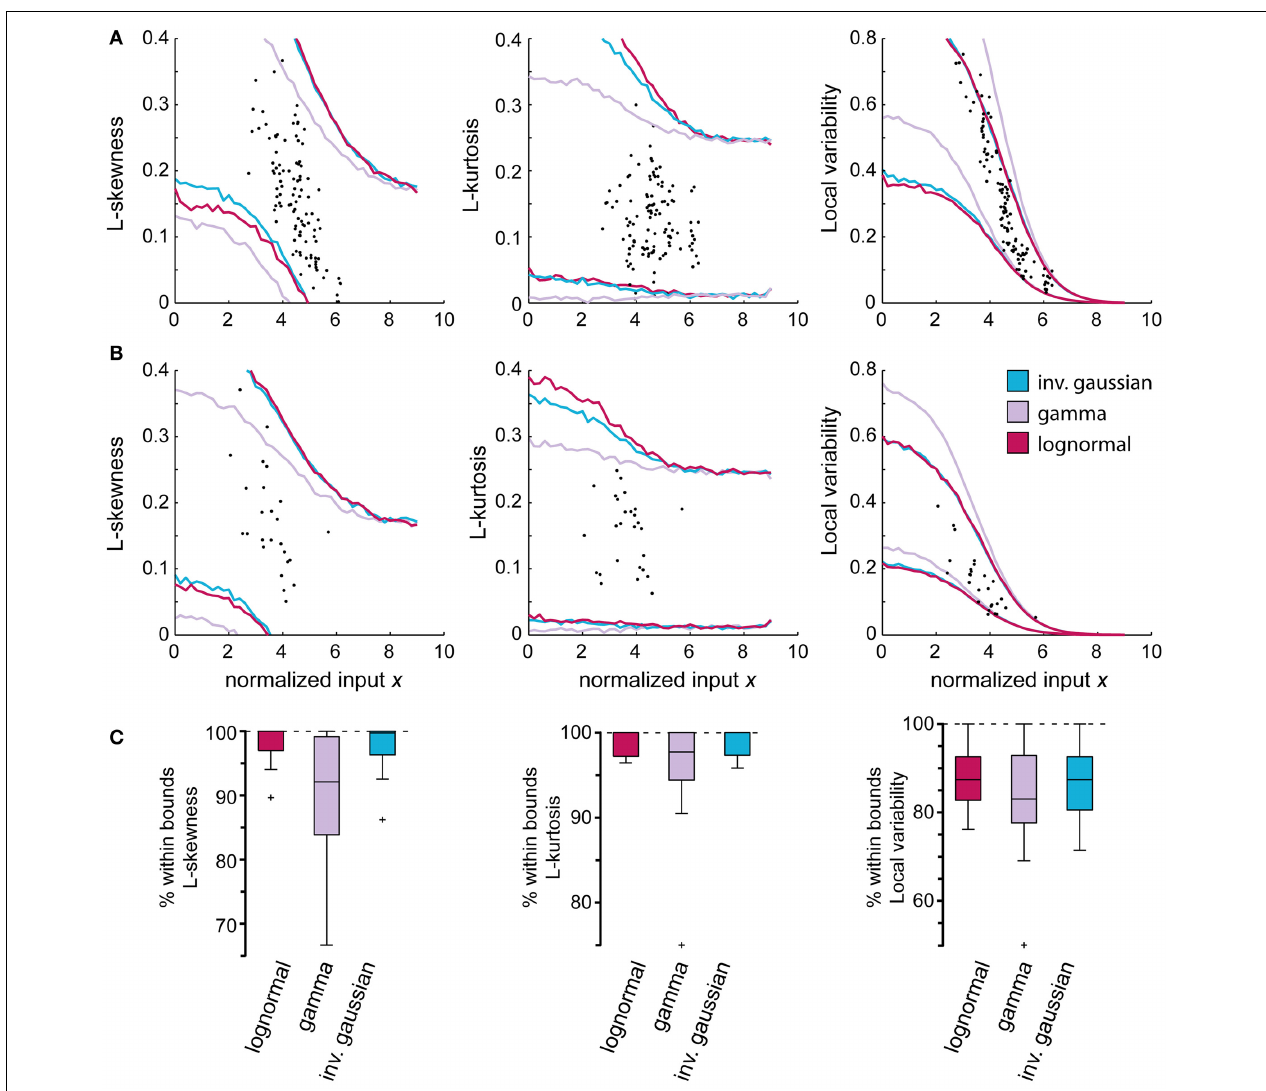
FIGURE 7 | Comparison between different probability density functions (PDFs) using higher order moments and the local variability (LV). Higher order moments of the empirical distributions and the local variability of the spike trains can be employed to validate the use of specific PDFs as approximations of the empirical distributions as they inform on features that cannot be seen using only the mean and standard deviation. (A,B) display the attained 99% confidence bounds of the constructed model using the gamma,